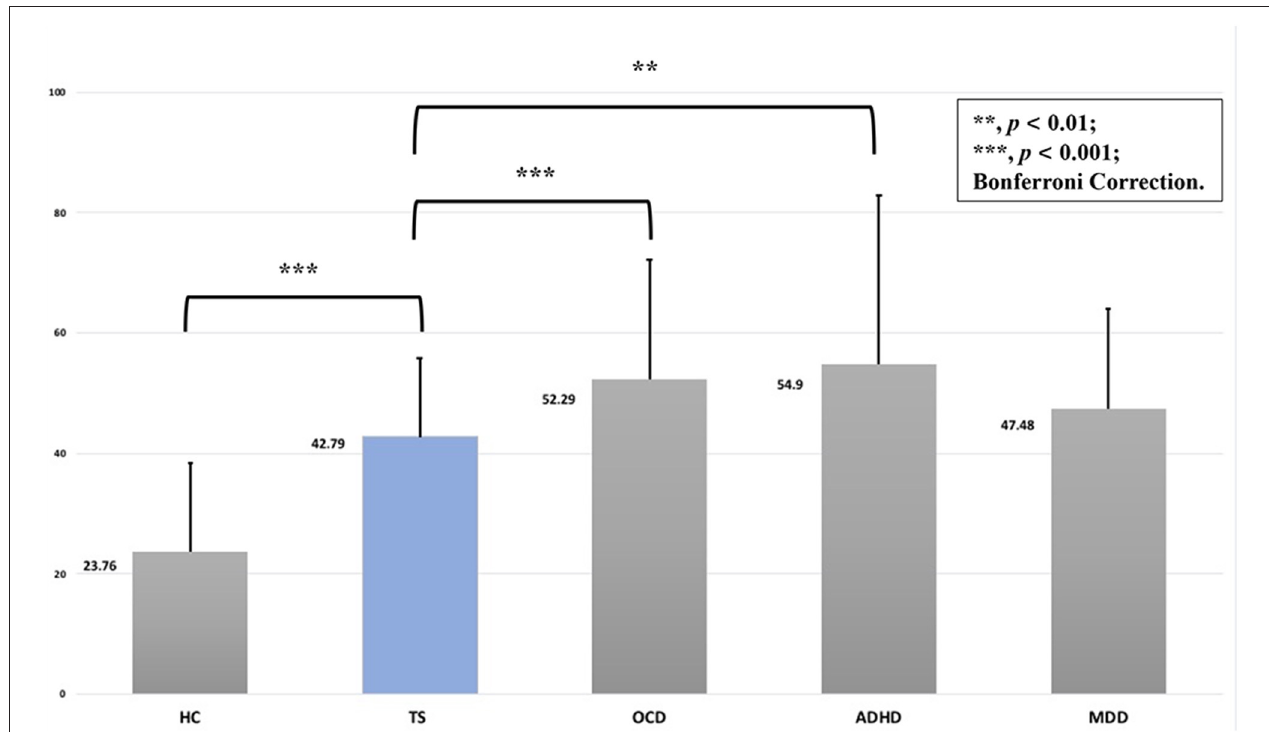
FIGURE 2 | The CBCL total scores of the TS and other compared